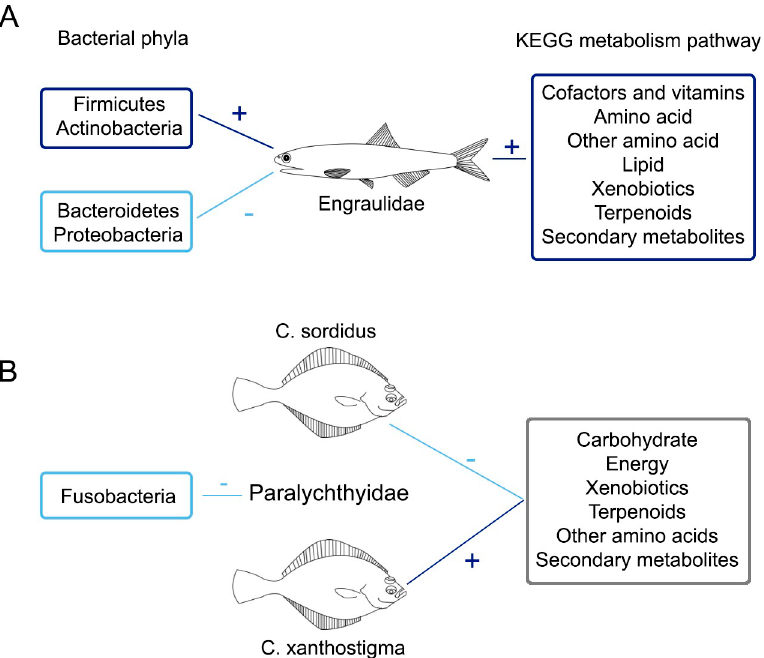
Fig 6. Significant correlations between prey consumed and gut microbiota function and composition. A) Relationship between the family Engraulidae and B) between members of the family Paralichthyidae. Positive (+, dark blue) and negative correlations (-, light blue) are